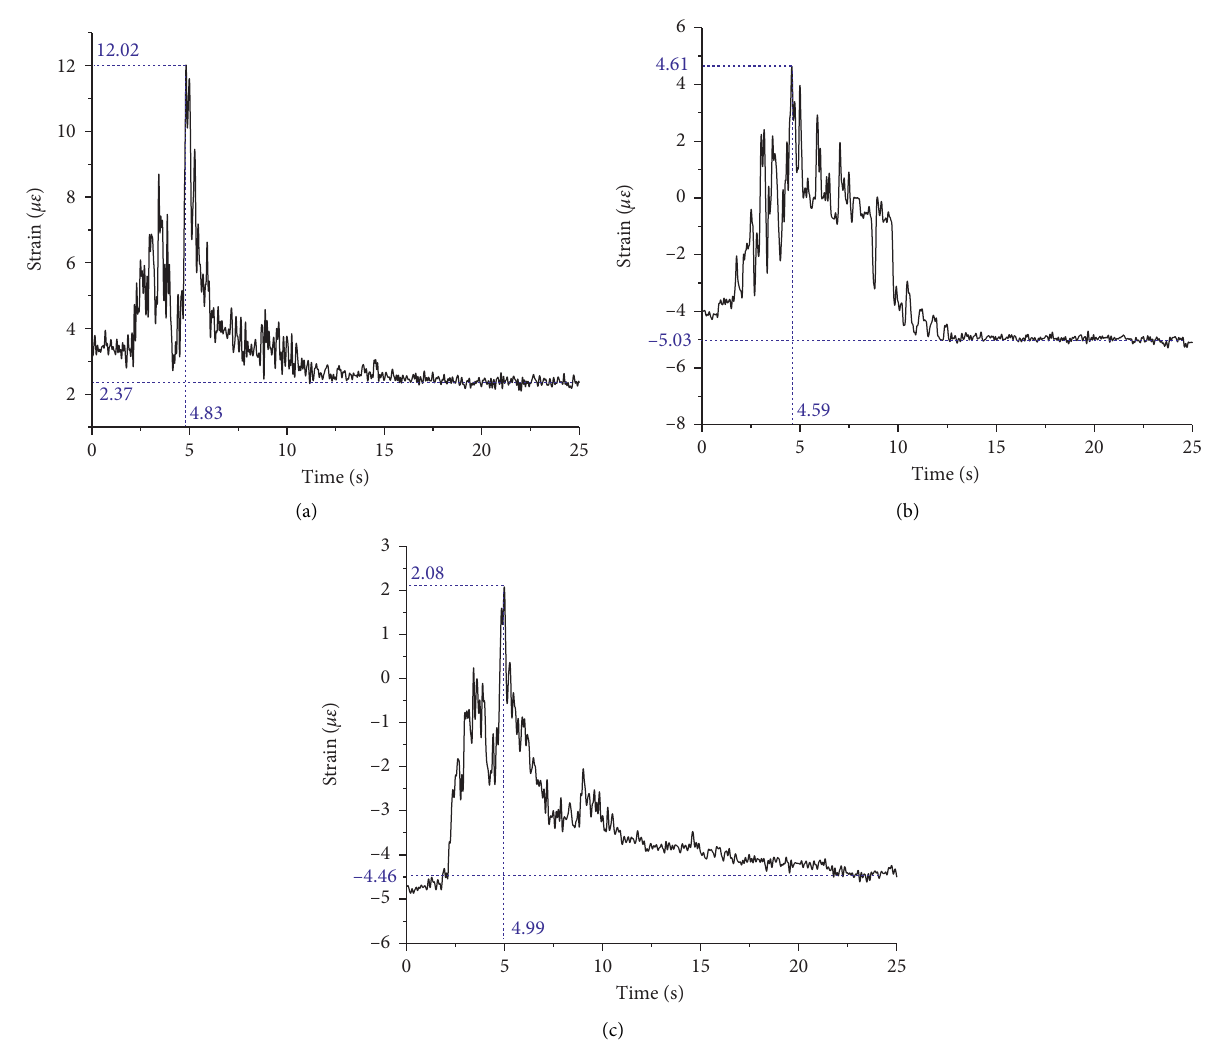
Figure 20: Time history curves of strain at the left hole arch foot: (a) X -direction strain ( ε strain ( ε 45 °